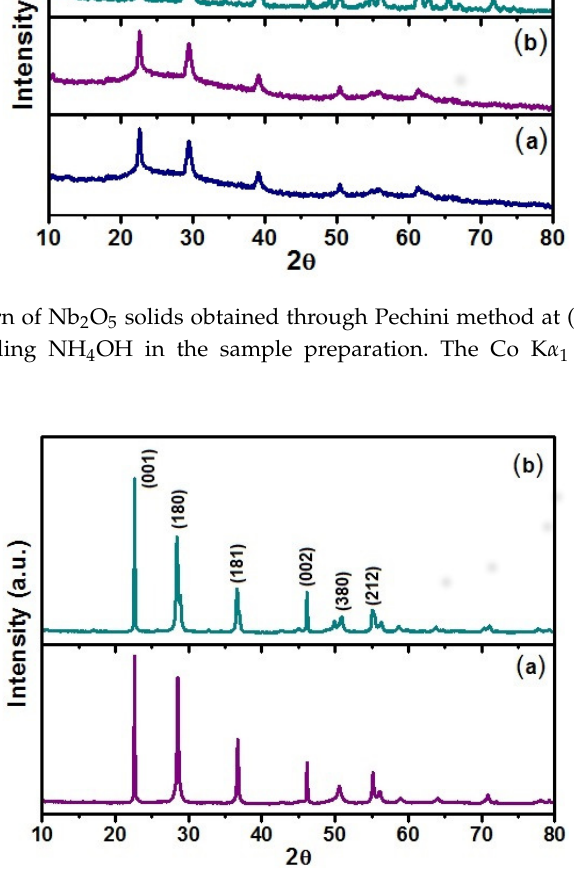
Figure 2. XRD pattern of Nb 2 O 5 solids obtained through sol-gel method at ( a ) 650 ◦ C and ( b ) 750 ◦ C, adding NH 4 OH in the sample preparation. The Cu K α 1 radiation was used to obtain the two